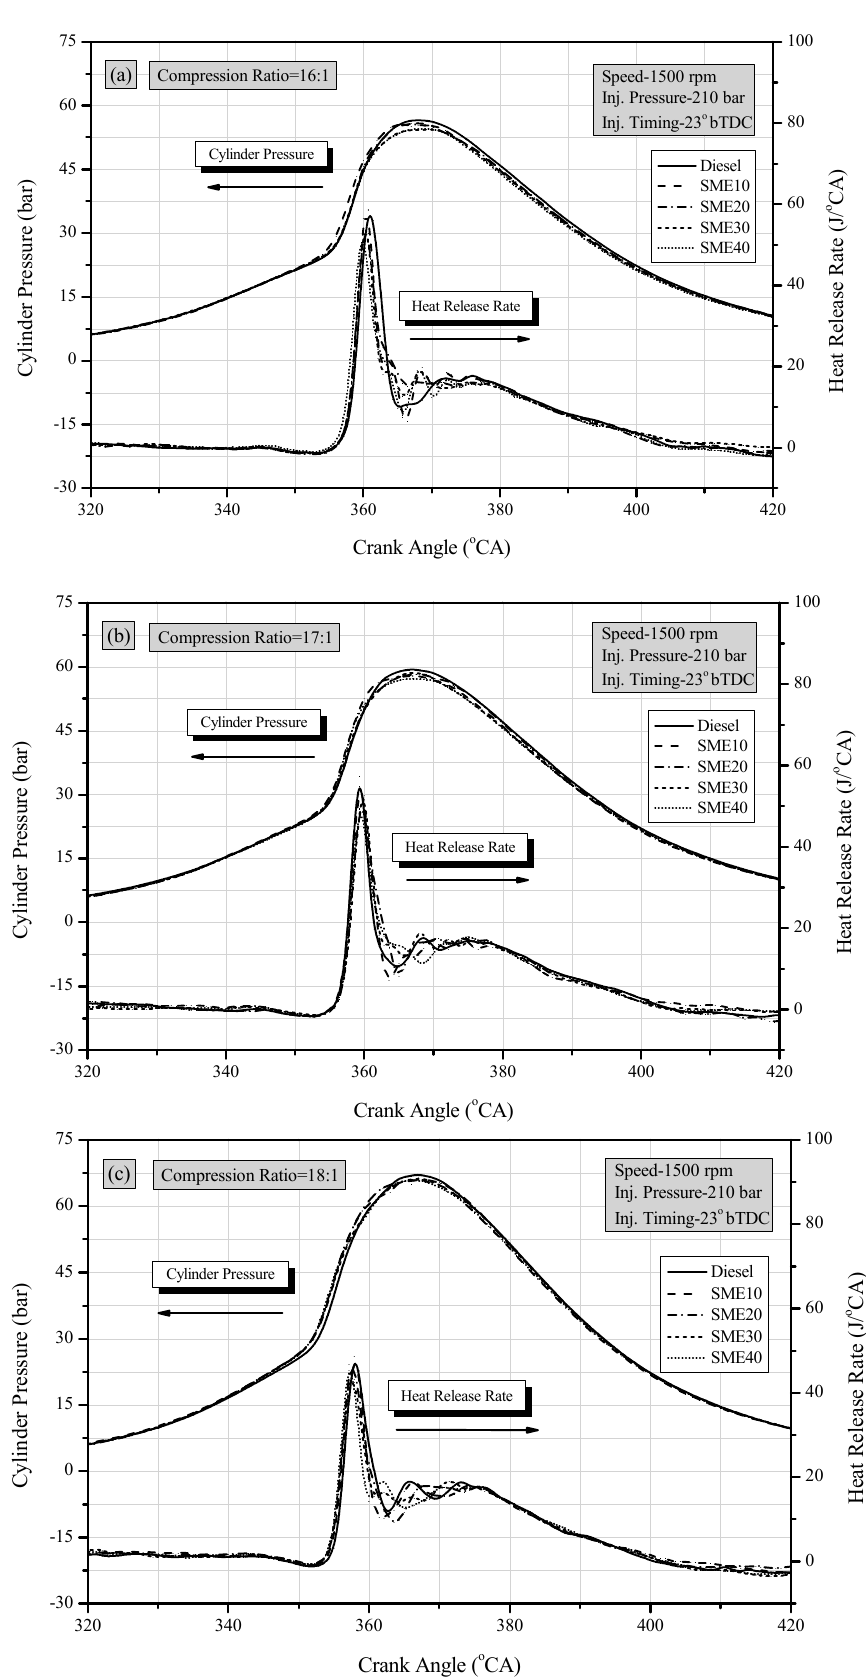
Figure 3. Variation of Cp and HRR with the crank angle for the fuel blends at CRs: ( a ) 16:1 ( b ) 17:1 ( c ) 18:1 and full load.